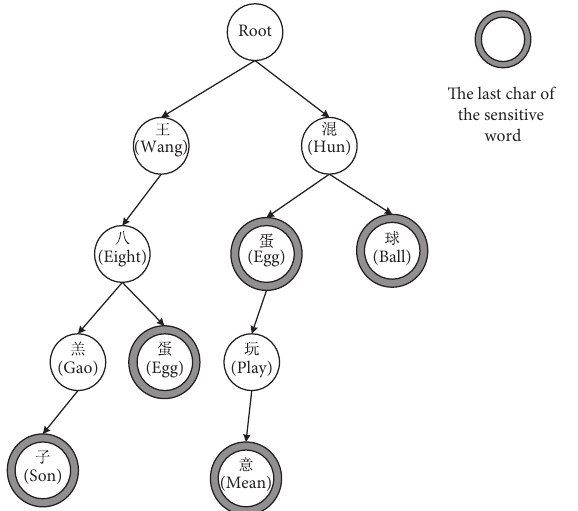
Figure 1: A typical example of sensitive word